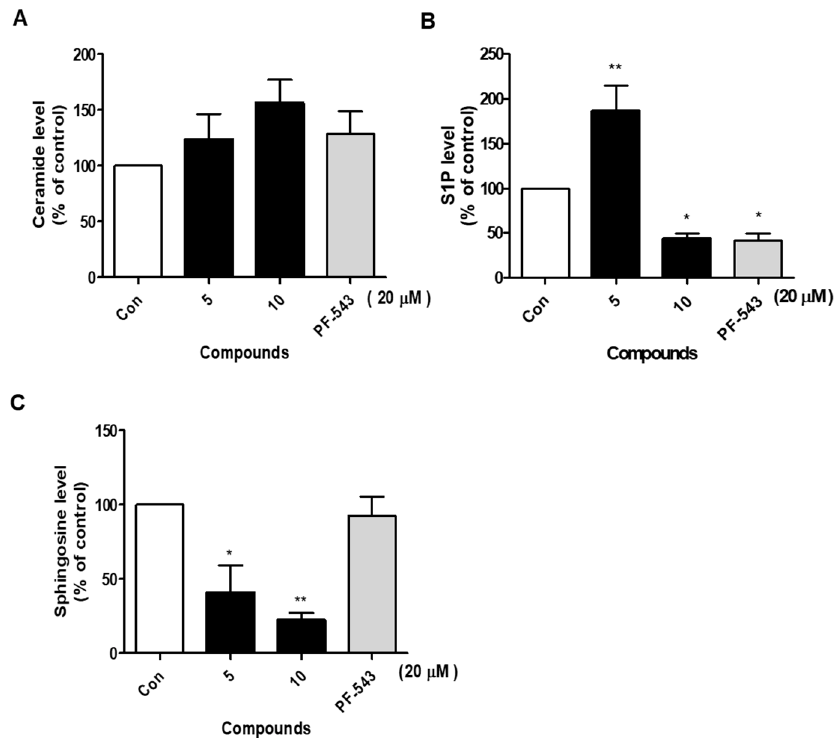
Figure 3. ( A ) Ceramide, ( B ) S1P, and ( C ) sphingosine levels were measured in MIA PaCa2 cells treated with compounds 5 , 10 , and PF543 at concentrations of 20 µM. The experiments were car- were considered significant at * p < 0.05 and ** p <